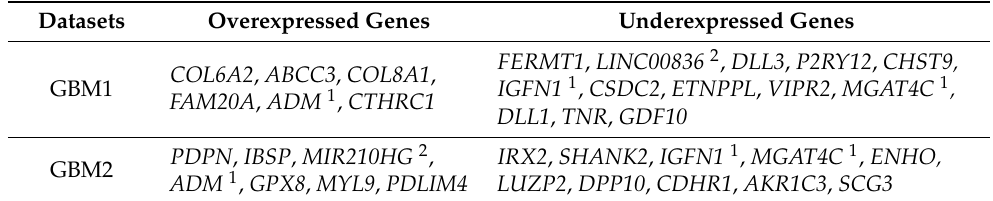
Table 2. Expression signatures of the 33 genes exhibiting high selective scores ( ≥ 2) in the GBM1 and GBM2